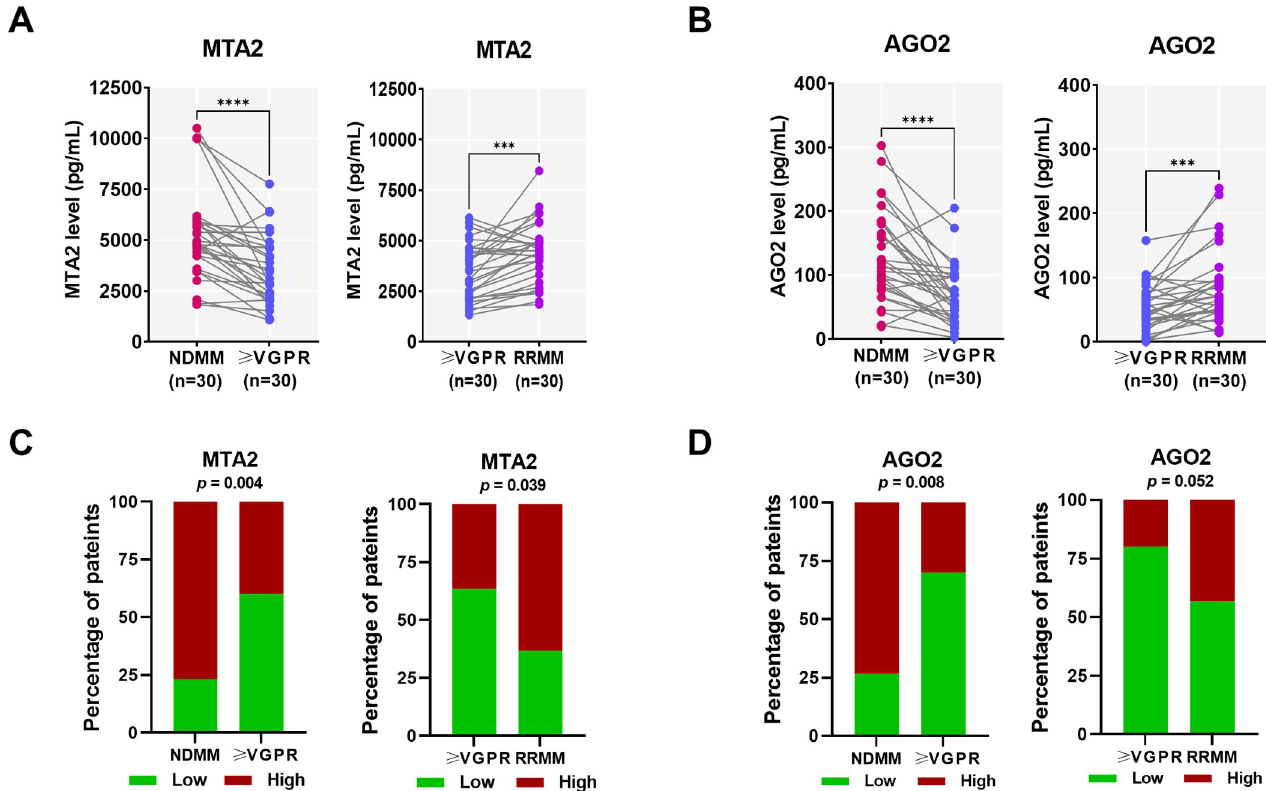
Fig 5. Serum MTA2 and AGO2 levels measured by ELISA in the validation cohorts. Comparison of serum (A) MTA2 and (B) AGO2 levels measured by the ELISA technique in NDMM and RRMM cohorts. � represents p < 0.05, �� represents p < 0.01, ��� represents p < 0.001 and ���� represents p < 0.0001. (C-D) The proportion of patients with high and low MTA2 and AGO2 levels in the NDMM and RRMM cohorts.